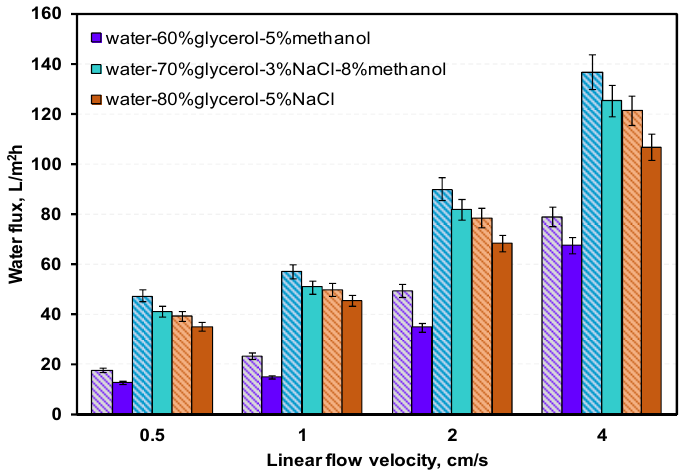
Figure 7. Water flux dependence of linear flow velocity in co-current (solid bars) and counter-current (striped bars) flow mode for different water–glycerol–salt–methanol draw solutions.